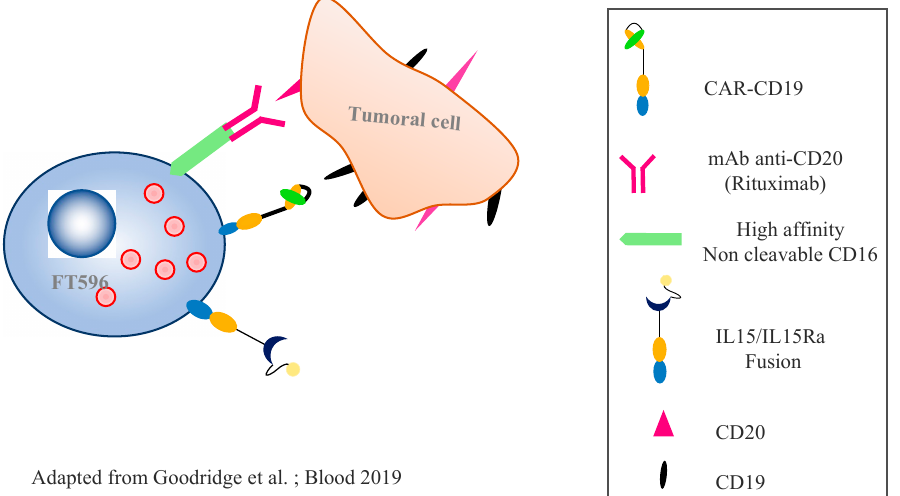
Figure 4. Mechanism of action of the FT596 cell, derived from iPSCs: The FT596 cell is composed of an anti-CD19 CR optimized for use in NK cells, with a transmembrane domain for the activating receptor NKG2D, a 2B4 costimulatory domain, and a CD3 ζ signalization domain. A high-affinity, non-cleavable CD16 Fc receptor (hnCD16) was added to increase antibody-dependent cell cytotoxicity by preventing negative regulation of the CD16, and by enhancing the CD16 bond with the tumor cells. A fusion IL-15/IL-15 receptor (IL-15RF) promoting cytokine-independent persistence was also added. When used in combination with monoclonal anti-CD20 antibodies (e.g., rituximab or